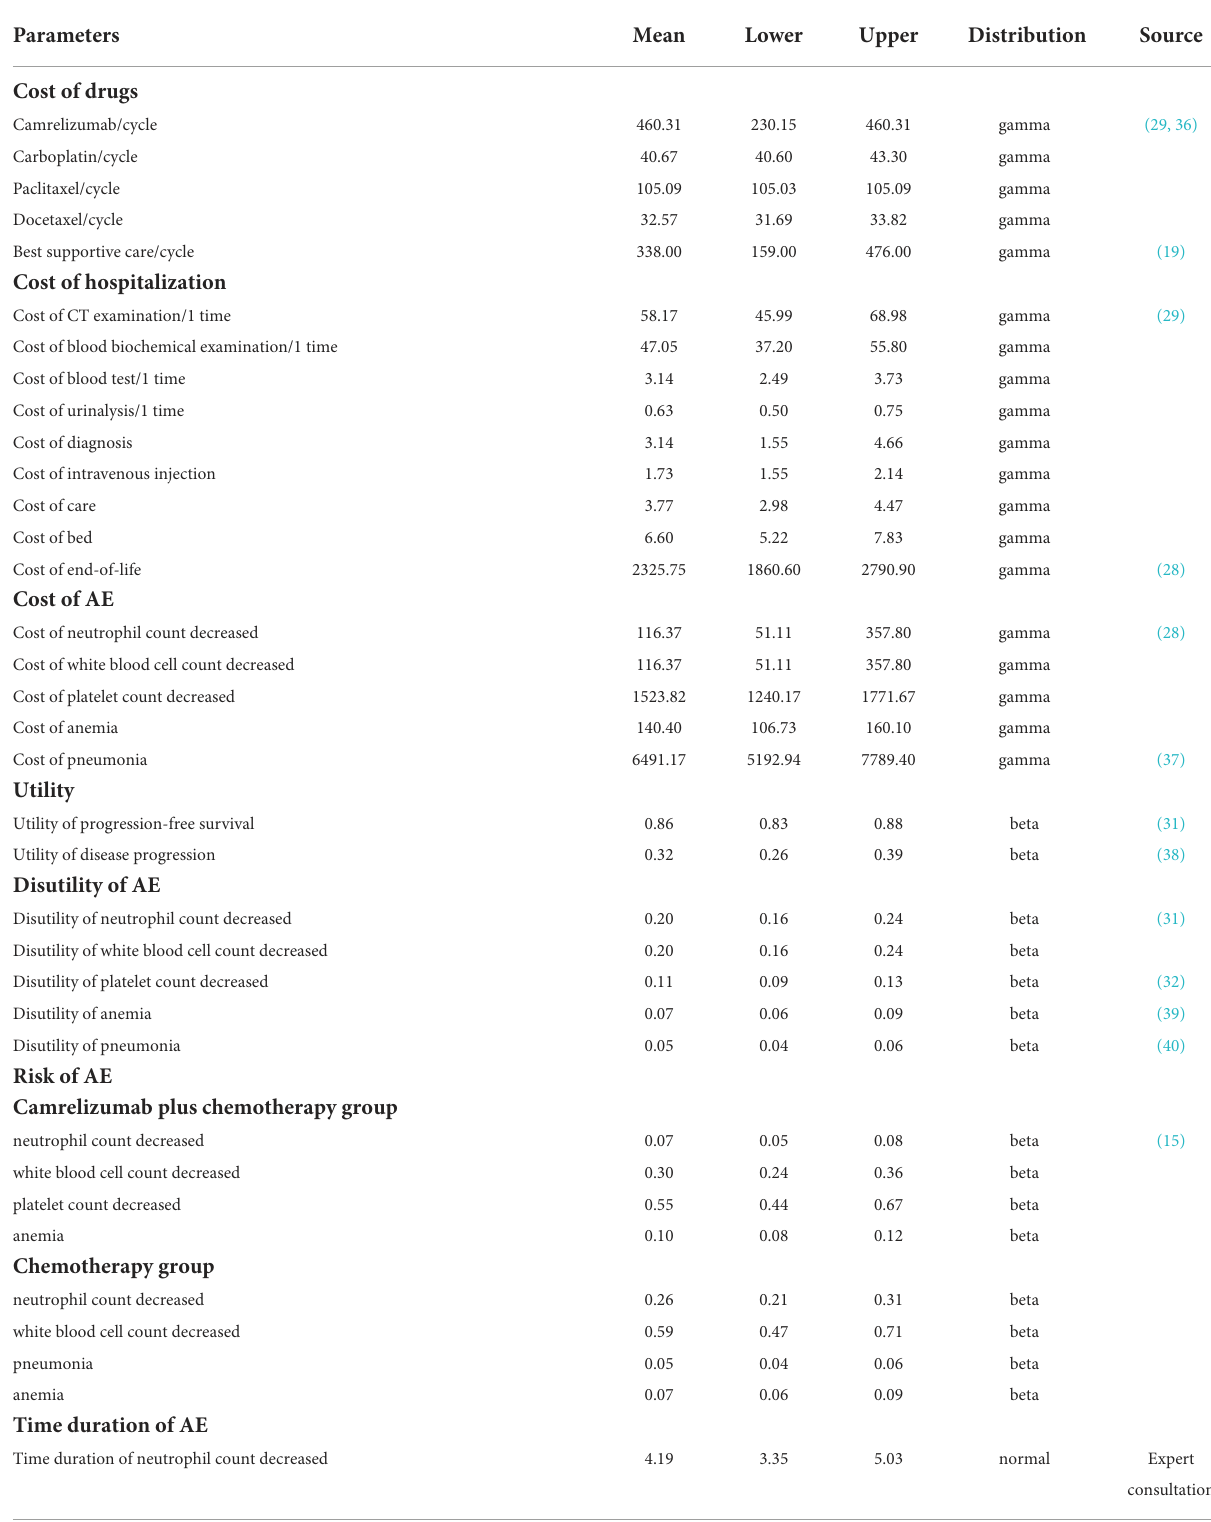
TABLE 1 Key model